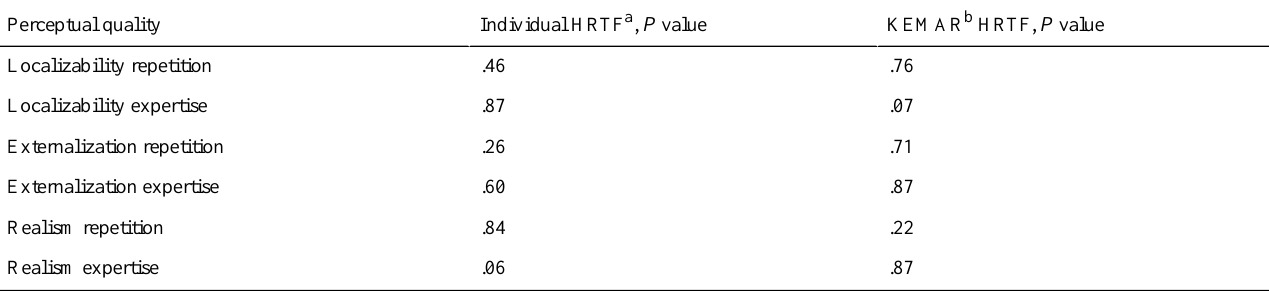
Table 2. Significance values of the subgroups for localizability, externalization, and realism in the first